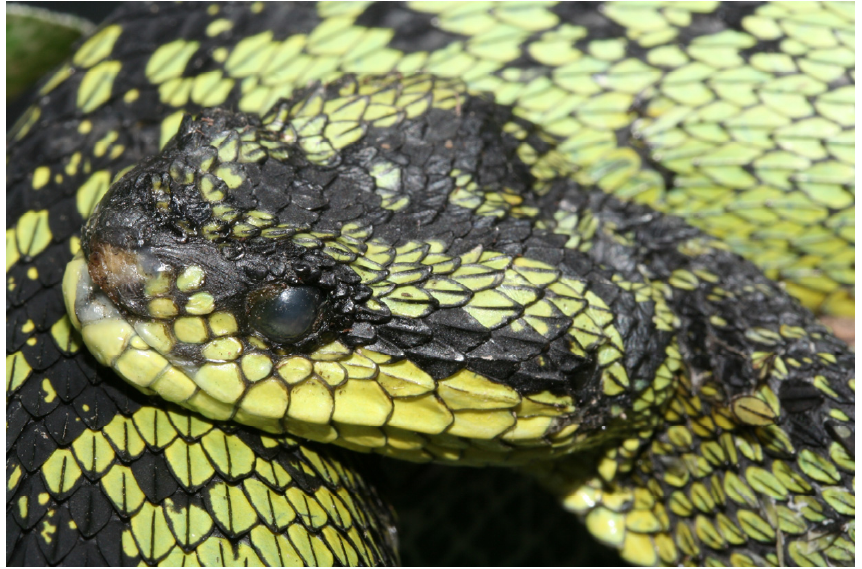
Figure 18. Dermatitis of the preocular and nasal skin extending to the medial part of the spectacle associated with opportunistic mycosis in a great lakes bush viper ( Atheris nitschei ).